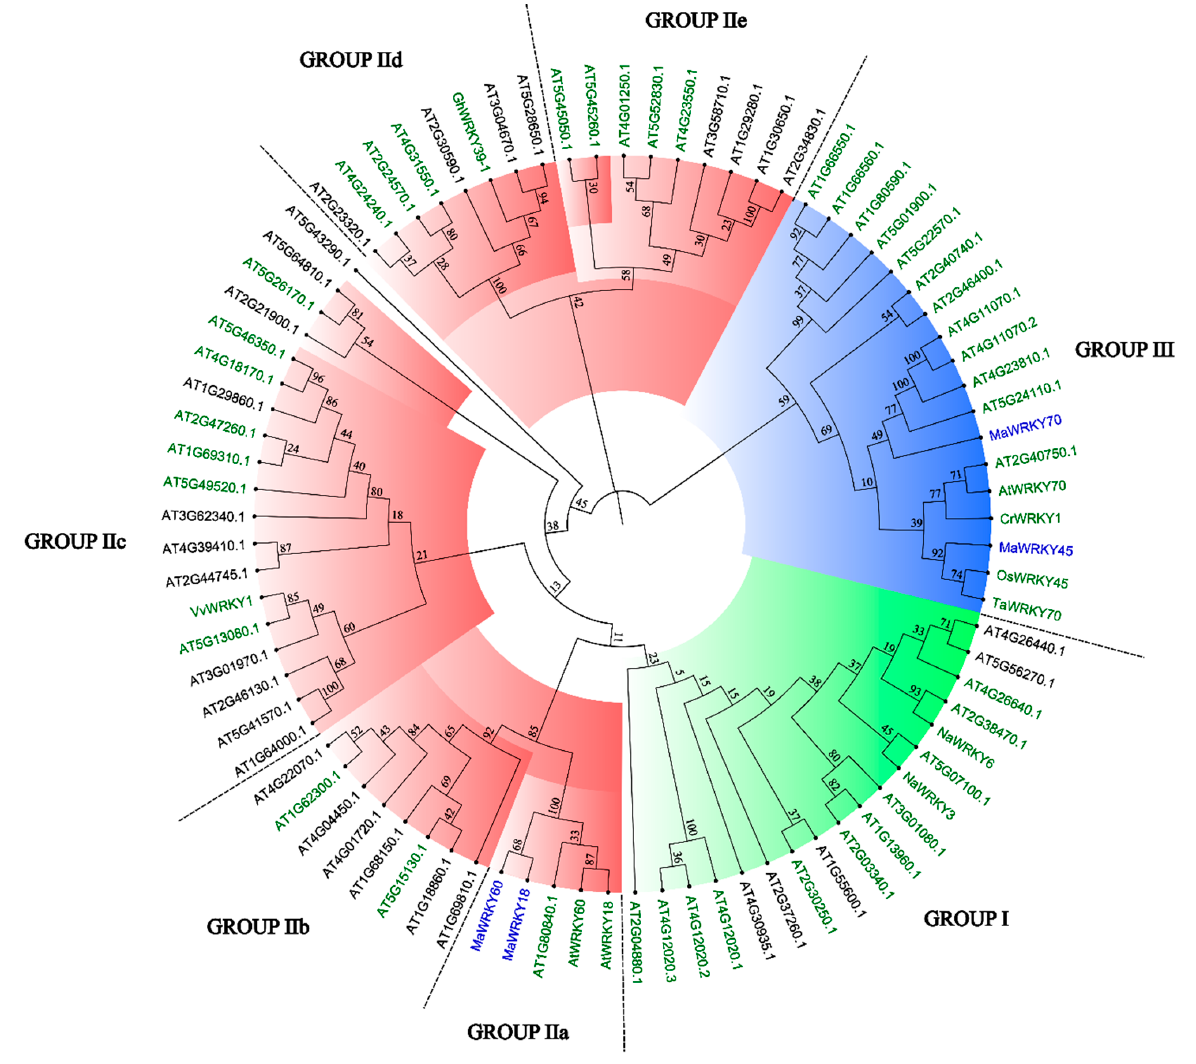
Figure 4. Neighbor-joining phylogenetic tree of MaWRKY18, MaWRKY45, MaWRKY60, and MaWRKY70 TFs, including the complete set of Arabidopsis WRKY TFs and other plant WRKY TFs with known functions. Groups I, II, and III of the WRKY TF family are highlighted in green, red, and blue, respectively. WRKY TFs with green names are involved in biotic stress responses. MaWRKY18, MaWRKY45, MaWRKY60, and MaWRKY70 are highlighted in blue. Numbers above branches are bootstrap values supporting the nodes based on 1000 bootstrap replications.